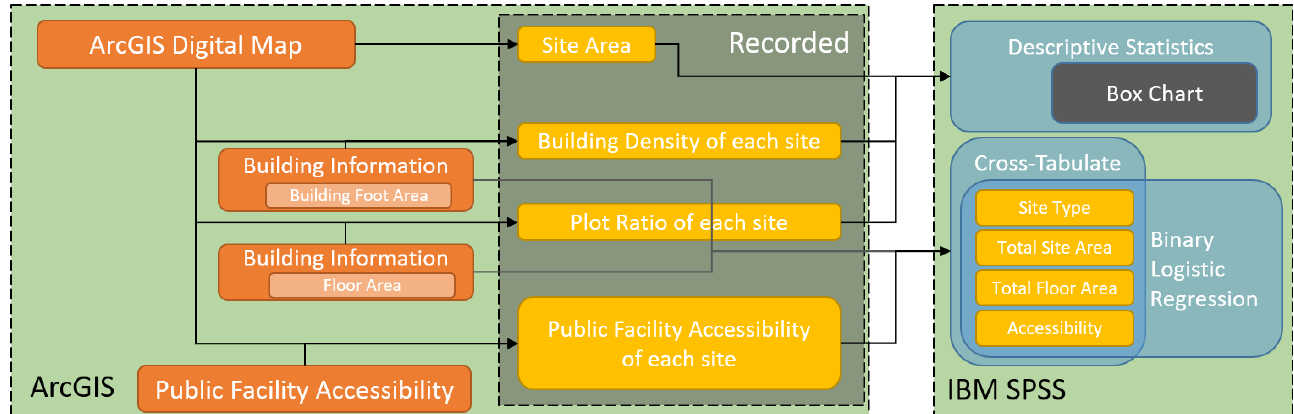
Figure 5. Statistical analysis